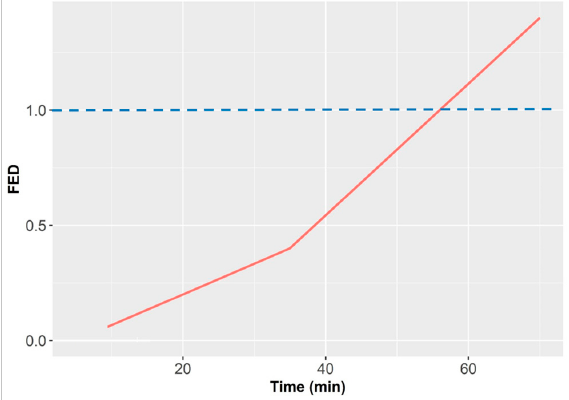
Figure 3. Time evolution of the toxic potency of the smoldering fire for the NIST test [40].